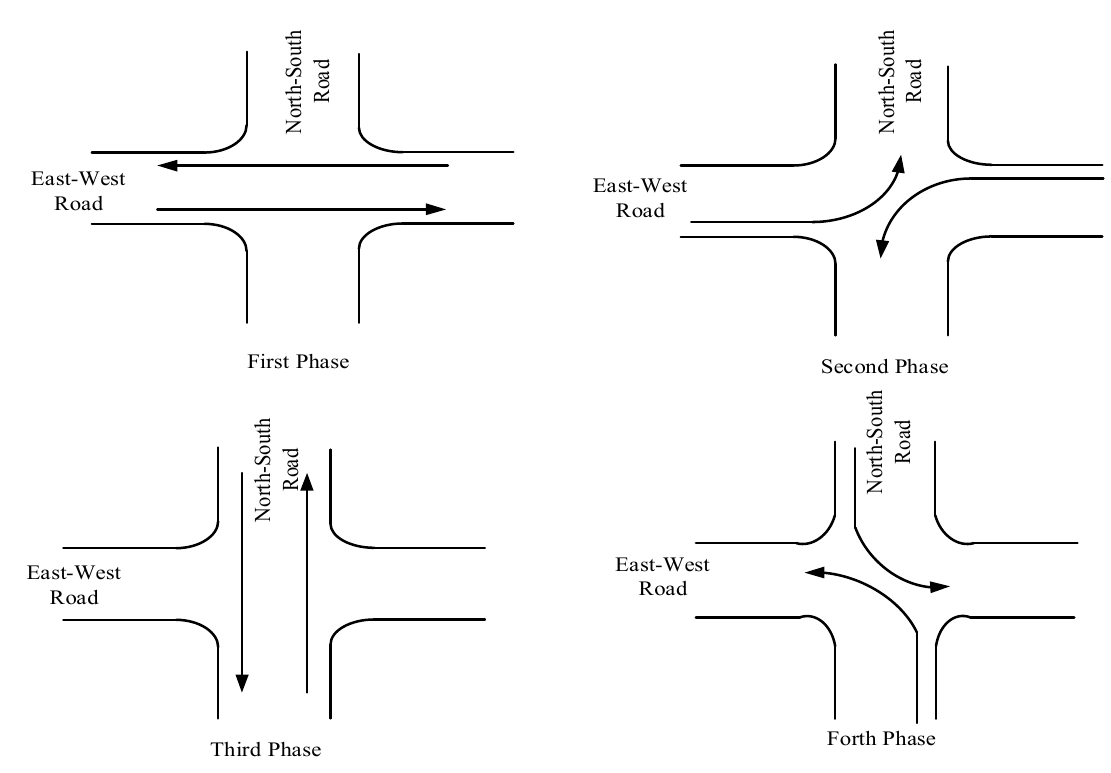
Figure 10. The traffic phase diagram at No. 3 intersection.